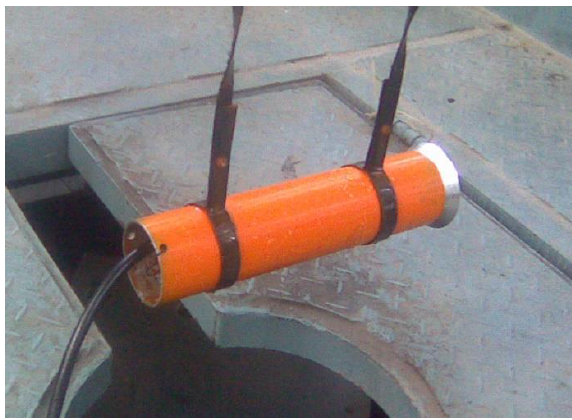
Figure 10. The Terfenol-D transducer prototype.